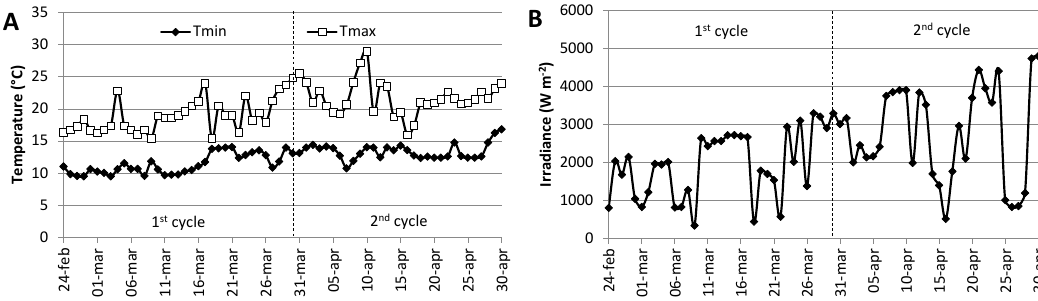
Figure 1. Meteorological conditions recorded during two growth cycles: temperature ( A ) and irradiance values ( B ) obtained from Zurich University of Applied Sciences (ZHAW) meteorological station.